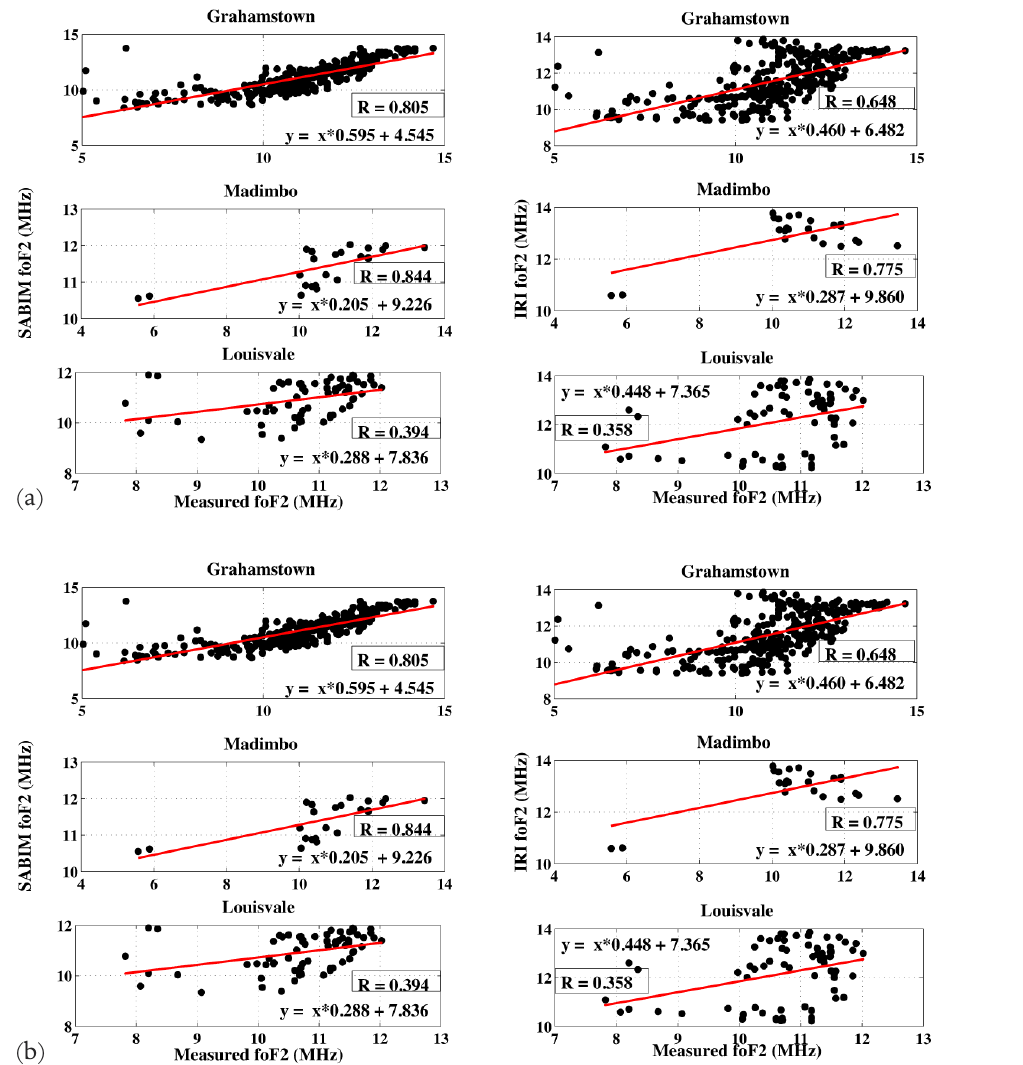
Figure 6. Scatter plots of annual foF2 values during solar maximum (Figure 6a) and solar minimum period (Figure 6b) at three ionosonde stations, Grahamstown, Madimbo and Louisvale. The left and right panels represent results from the SABIM model and the IRI-2012 model respectively.